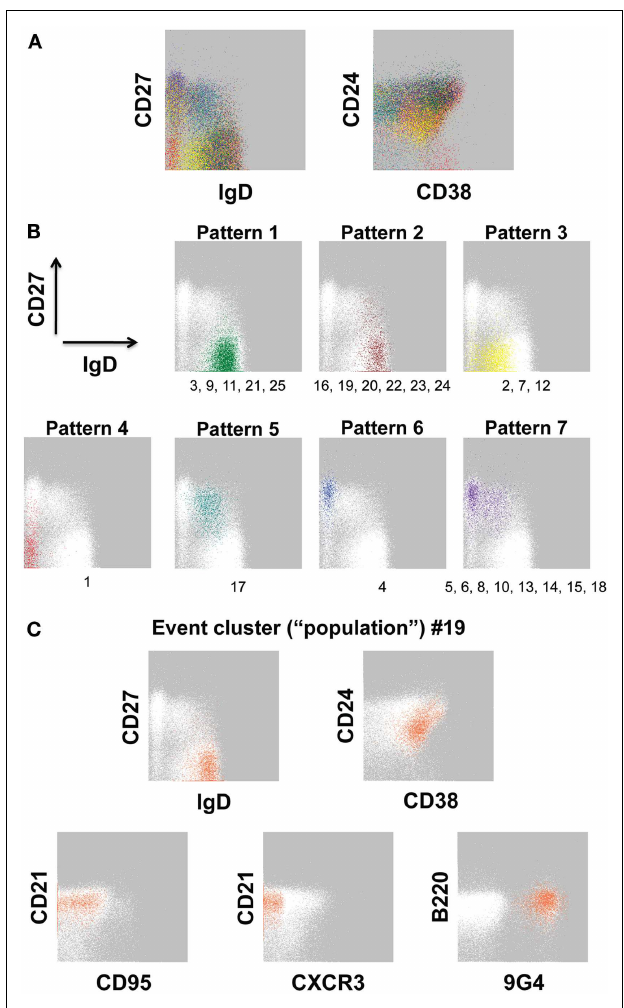
FIGURE 2 | Event clusters identified by FLOCK analysis. FLOCK (Qian et al., 2010) version 1.0 was run unsupervised on human PBMC stained with the 12-color memory B cell reagent panel described in OMIP-003 (Wei et al., 2011) pre-gated on single, viable CD19 + lymphoid events. (A) Overlay of 25 populations, indicated in unique colors, identified in the sample displayed as two-dimensional plots. (B) Representative event clusters of the indicated Patterns based on CD27 versus IgD signals. Numbers below the plots indicate IDs of populations (see Table 3 ) with similar event distributions as displayed in the corresponding plot. (C) Population 19 displayed as all parameters analyzed by FLOCK. In (B,C) , white events on the gray background are the total CD19 + population, for reference. Characteristics of all 25 populations can be found in Table 3